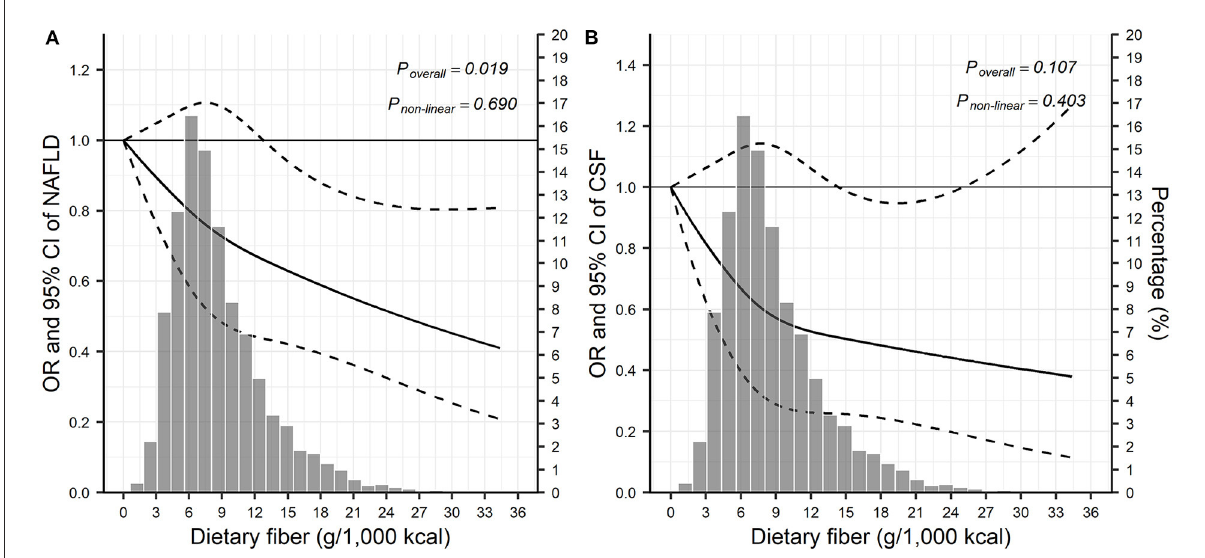
FIGURE1 Visualization of the dose-response relationship between dietary fiber and liver disease based on restricted cubic splines a . (A) The relationship between dietary fiber and NAFLD; (B) the relationship between dietary fiber and CSF. CI, confidence interval; CSF, clinically significant fibrosis; NAFLD, non-alcoholic fatty liver disease; OR, odds ratio. a Model was adjusted for adjusted for age, sex, smoking, race/ethnicity, education, ratio of family income to poverty, physical activity, total energy, hypertension, and diabetes.